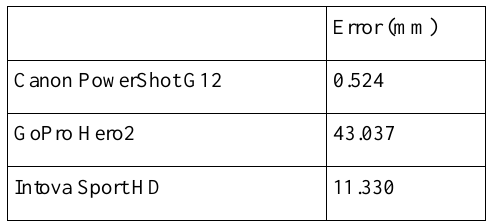
Table 11. Comparison of total errors related to used